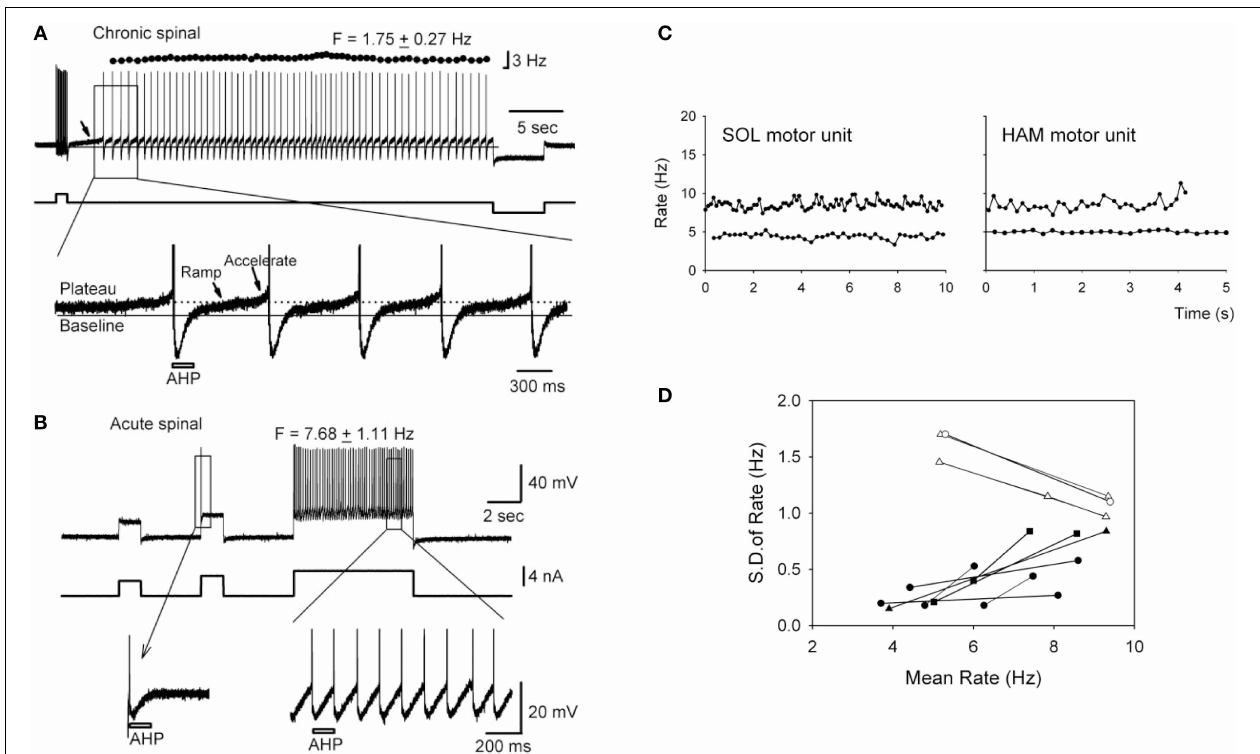
FIGURE 2 | Slow, steady firing in rat and human motoneurons after chronic SCI. (A) Top trace: Firing response of a motoneuron from a chronic spinal rat in response to a brief depolarizing current pulse ( ∼ 2 nA). Note low mean rate (1.75Hz) and small standard deviation ( ± 0.27Hz) in firing. Bottom trace: Magnification of top trace indicated by rectangle. Plateau activation due to NaPIC is indicated by dotted line, and baseline membrane potential (Vm) is represented by solid black line. Note the ramp and acceleration (arrows) in Vm after each AHP due to NaPIC, producing interspike intervals much longer than the duration of the AHP (gray bar). (B) Top trace: Firing response of motoneuron from an acute spinal rat without plateau potentials in response to large ( ∼ 4–5 nA) depolarizing current injections. Note increased